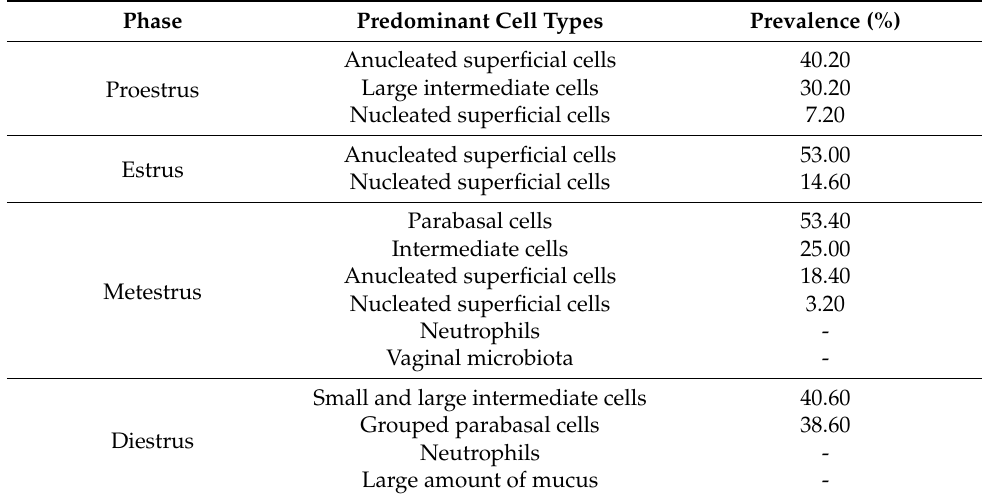
Table 4. Vaginal cytology during the different estrous cycle phases, according to de Oliveira et al. [42]. Phase Predominant Cell Types Prevalence (%)